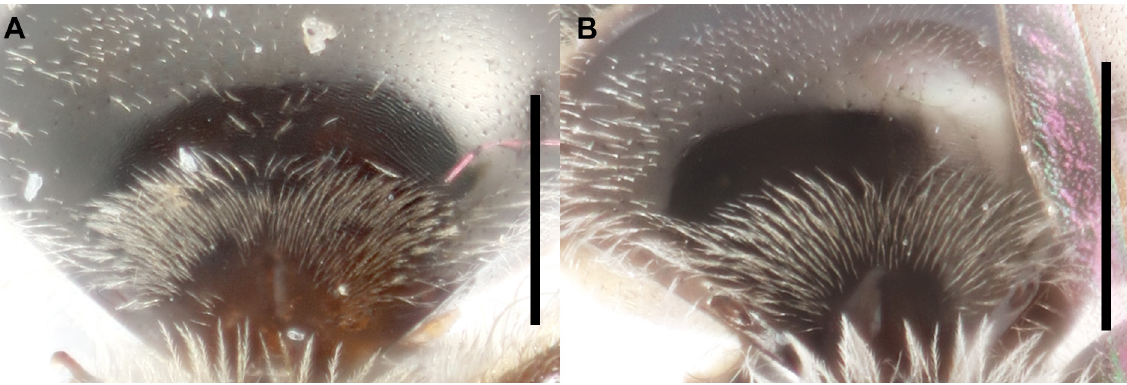
Fig. 92. T1 anterior slope. A . Lasioglossum puteulanum Gibbs, 2009, ♀, coriarious. B . L. angelicum sp. nov., ♀, smooth and shiny. Scale bars = 0.5 mm.